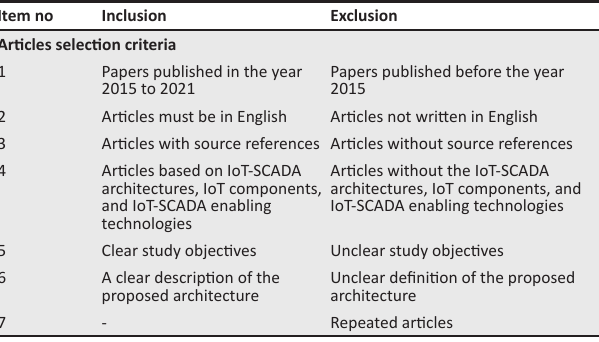
TABLE 2: The studies selection